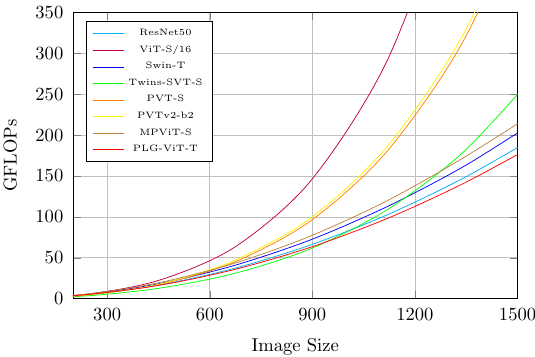
Figure 5. Complexity evaluation (GFLOPs) under different input sizes. The growth rate of GFLOPs: ViT-S/16 [14] > PVTv2-b2 [19] > PVT-S [13] > Twins-SVT-S [16] > MPViT-S [20] > Swin-T [12] > ResNet50 [1] > PLG-ViT-T (ours). All values are based on reproduced results.